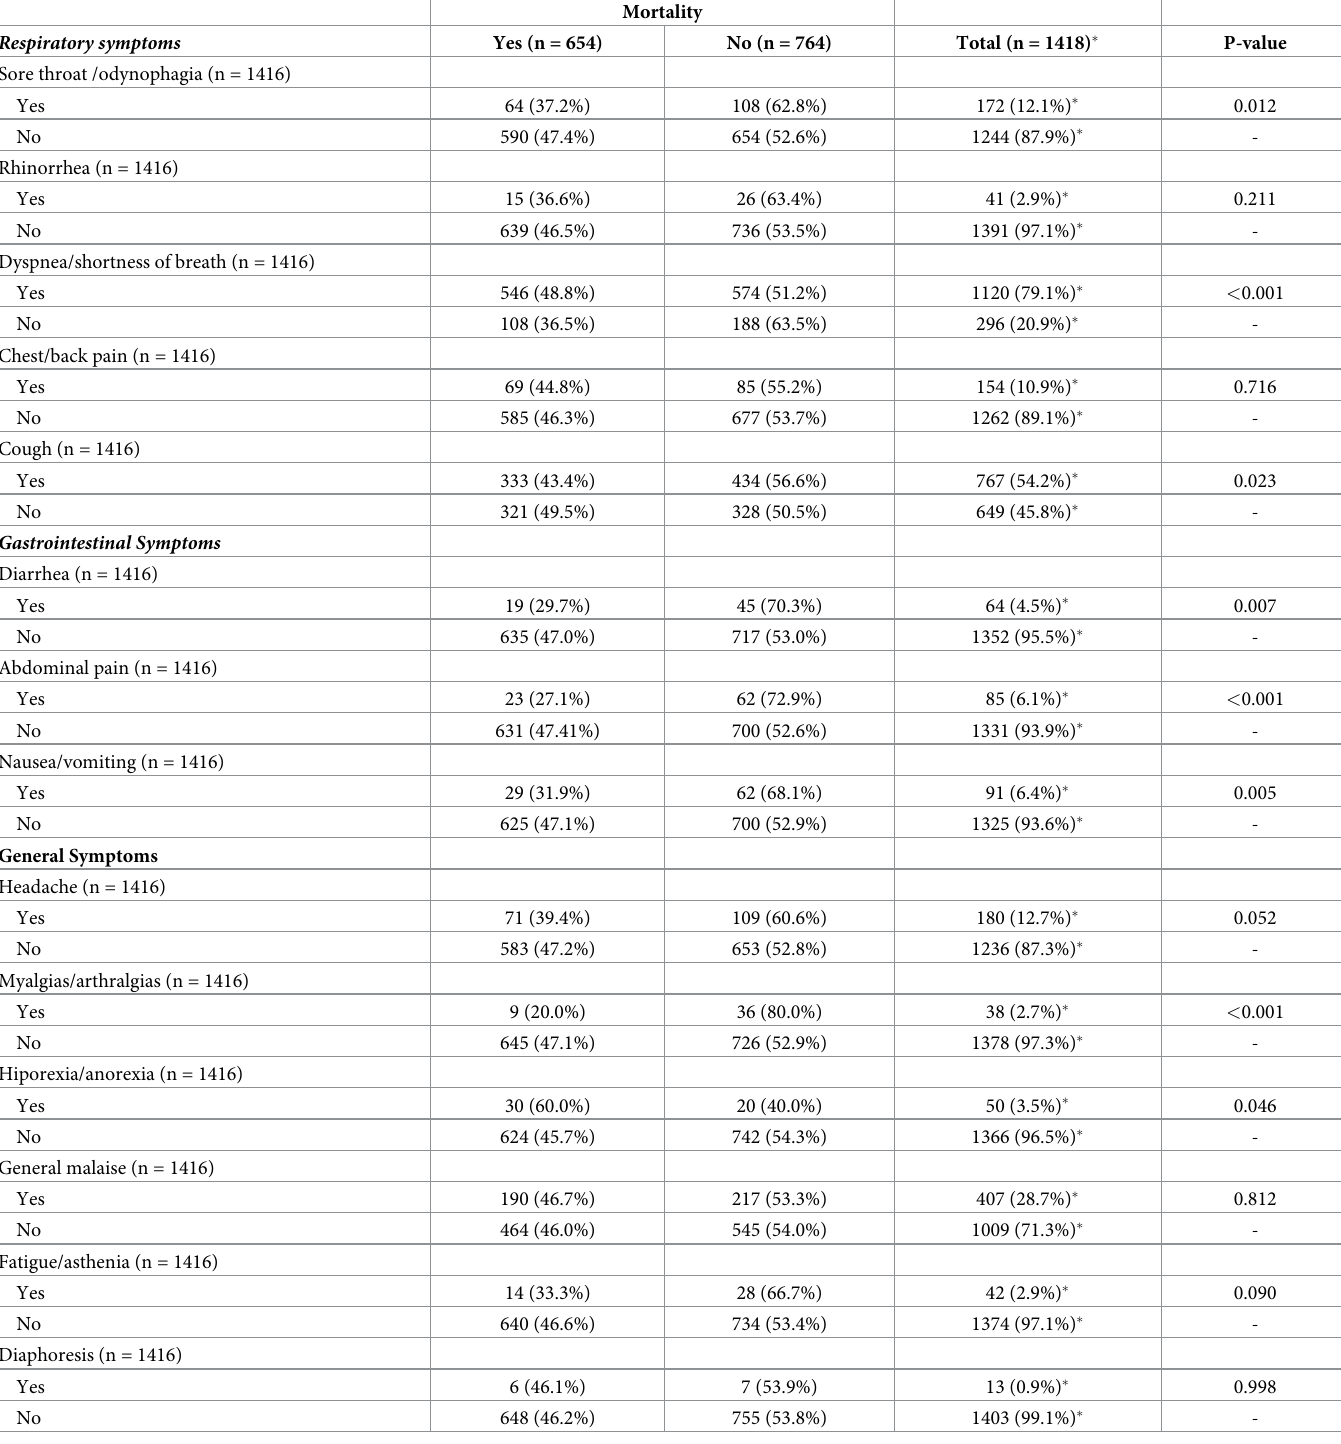
Table 2. Symptoms reported in patients hospitalized for COVID 19 admitted to Hospital Nacional Hipo´lito Unanue from April to August 2020. Lima,